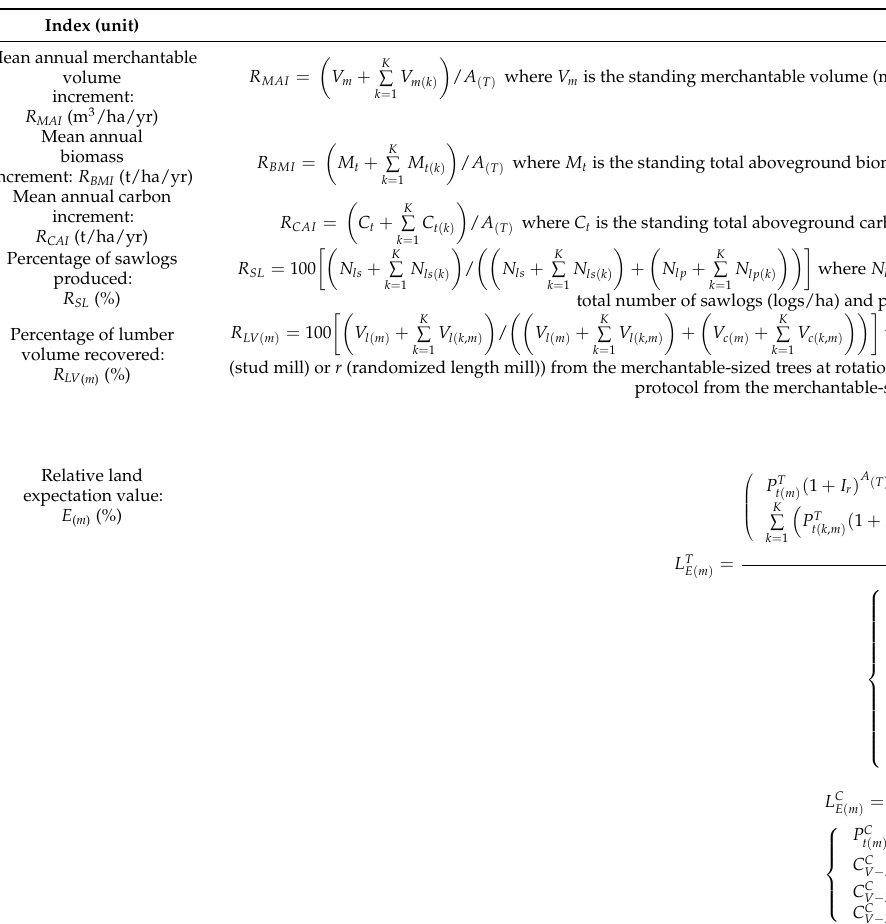
Table A1. Stand-level performance indices: denotations and computations (sensu